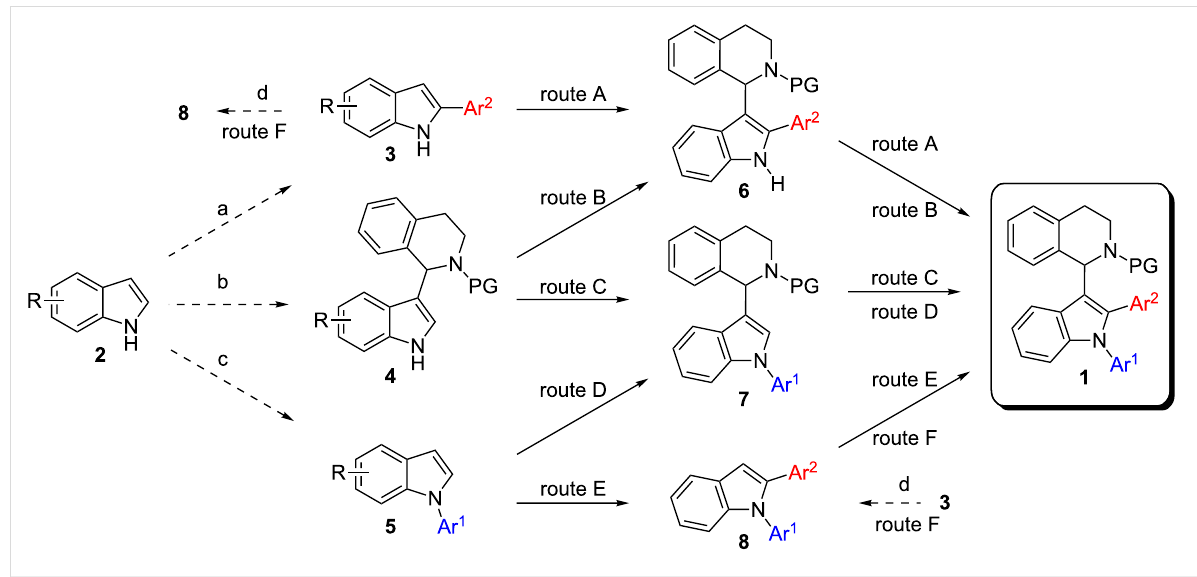
Scheme 2: Possible strategies for the synthesis of target structure 1 . Dashed arrows indicate literature-known pathways consequently not investi- gated in this contribution. a: see [32-45]; b: see [15-23]; c: see [46-49]; d: see